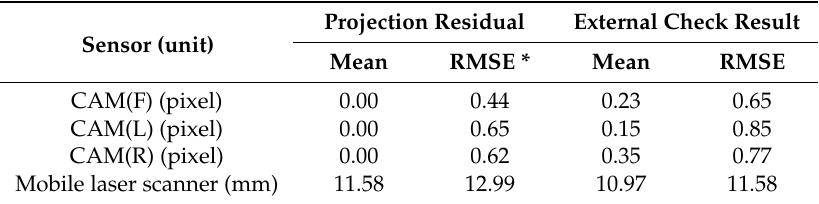
Table 7. Projection residual and external check result of boresight and lever-arm calibration.